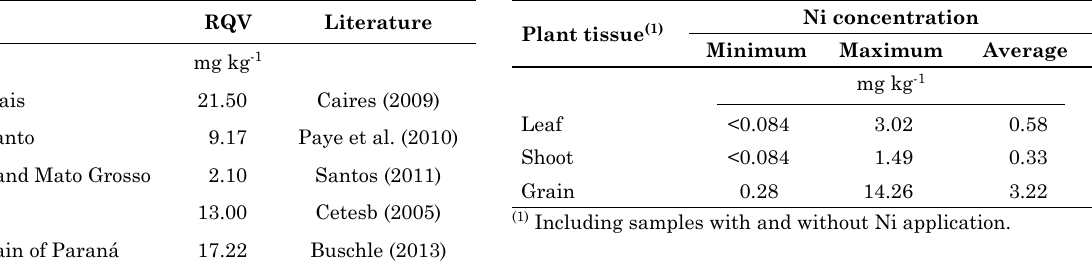
Table 6. Correlations between Ni in soil (Mehlich-1 and dtPa), leaf, grain and shoot of soybean plants grown in soils with different levels of